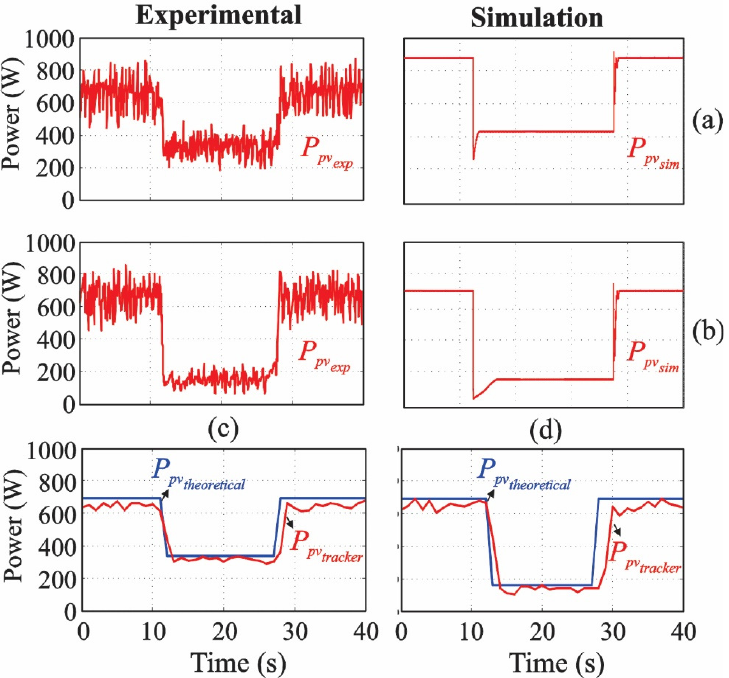
Figure 10. PV array output power considering temperature changes of ( a ) 10 °C and ( b ) 30 °C with S = 800 W/m 2 . Comparison between the theoretical and the tracked maximum power point during the temperature changes ( c , d ).